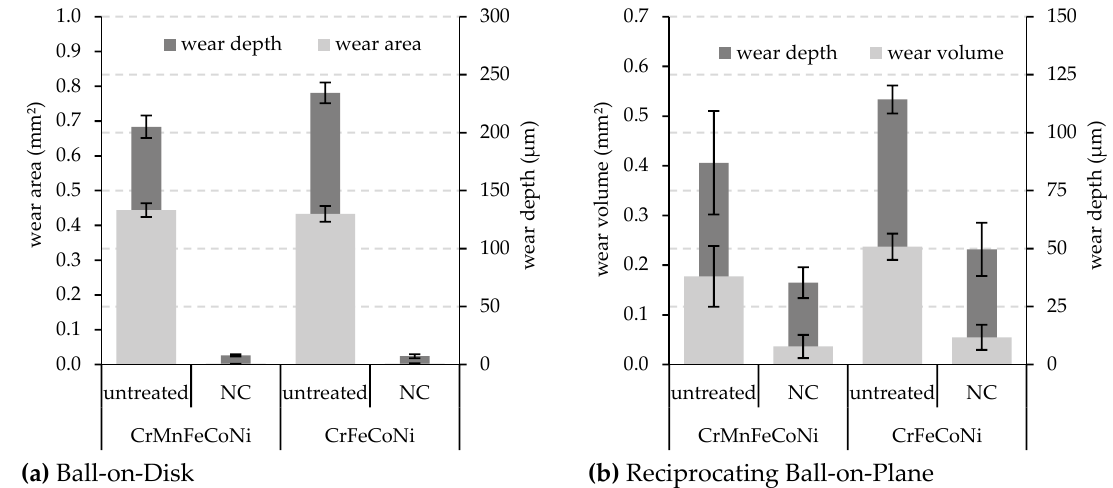
Figure 5. Wear values of CrMnFeCoNi and CrFeCoNi in dependence of the treatment state and wear condition.